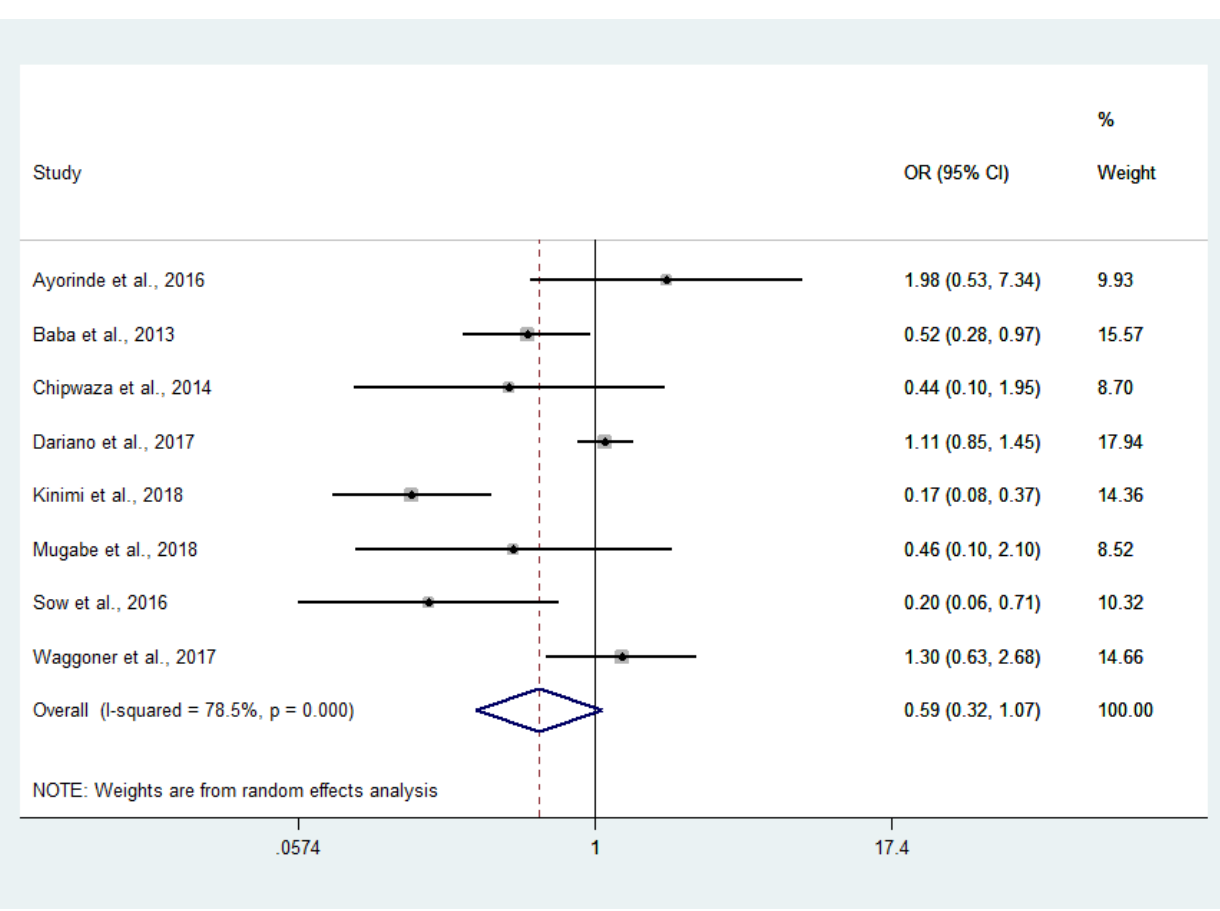
Figure 8. Odds of malaria and CHIKV coinfections: % weighted, the impact proportion of each study to the pooled effect; the black dot symbol on the black horizontal line, the point estimate for each study; the black horizontal line, CI; the white diamond symbol, the pooled prevalence; CI, confidence interval; ES, effect size (prevalence).